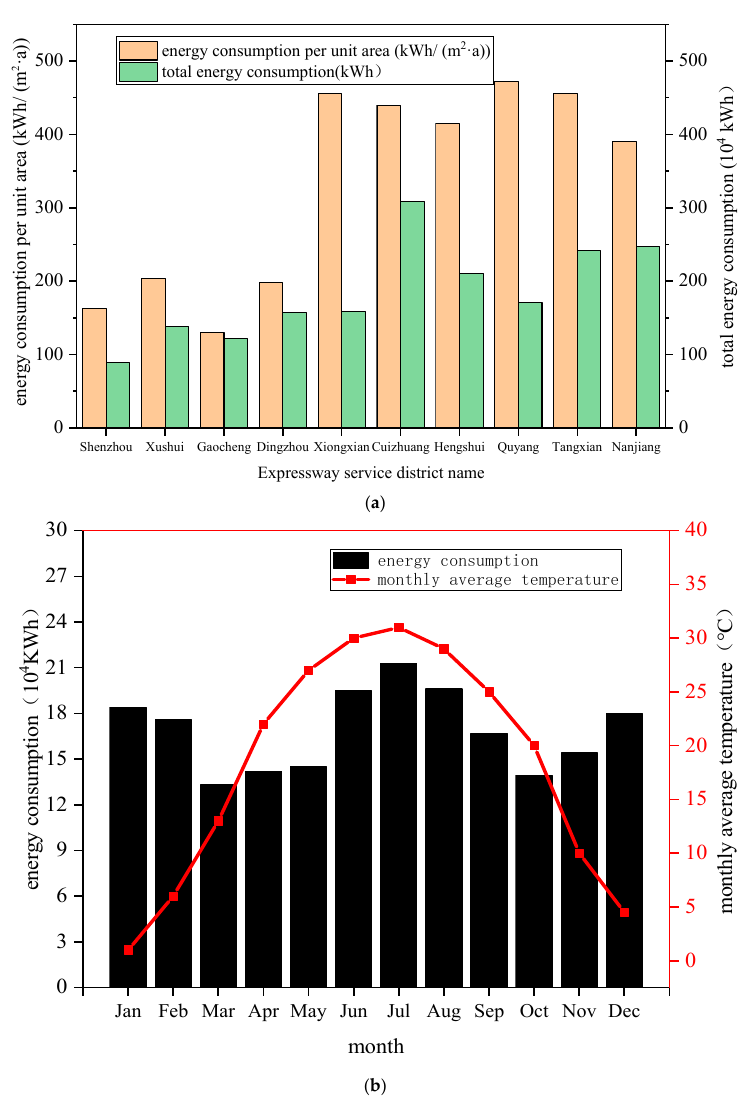
Figure 1. Energy consumption and monthly temperature of expressway service buildings in 2019. ( a ) Building Energy consumption of typical expressway service districts in 2019. ( b ) Monthly building energy consumption and average temperature of new